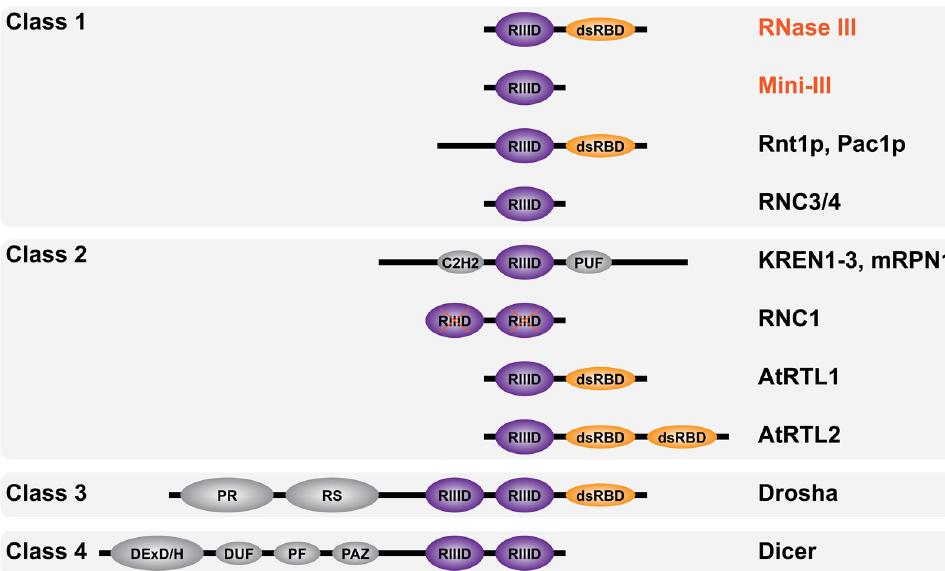
Figure 4. Domain diversity of RNase III enzymes. Schematic representation of RNase III enzymes domain composition categorized by classes as described in the text (not to scale). Bacterial RNase III are in red font and eukaryotic RNase III in black font. The RNase III catalytic domain (RIIID) is in purple and marked with a red X when inactive (in RNC1), the double-stranded RNA binding domain (dsRBD) is in orange while the Zinc finger domain C2H2, RNA-binding domain PUF, proline-rich domain PR, arginine/serine (RS)-rich domain, helicase DExD/H domain, RNA annealing domain DUF, structural domain PF and the anchoring domain PAZ are in gray.